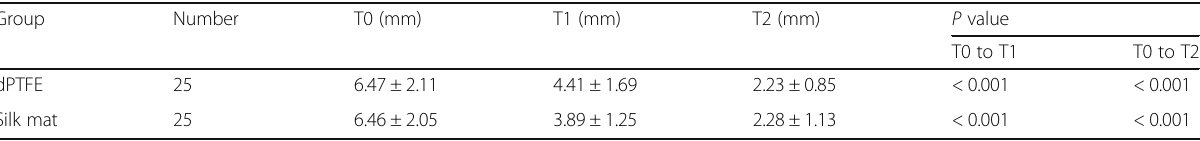
Table 2 Summary of bone defect in patients with membrane Group